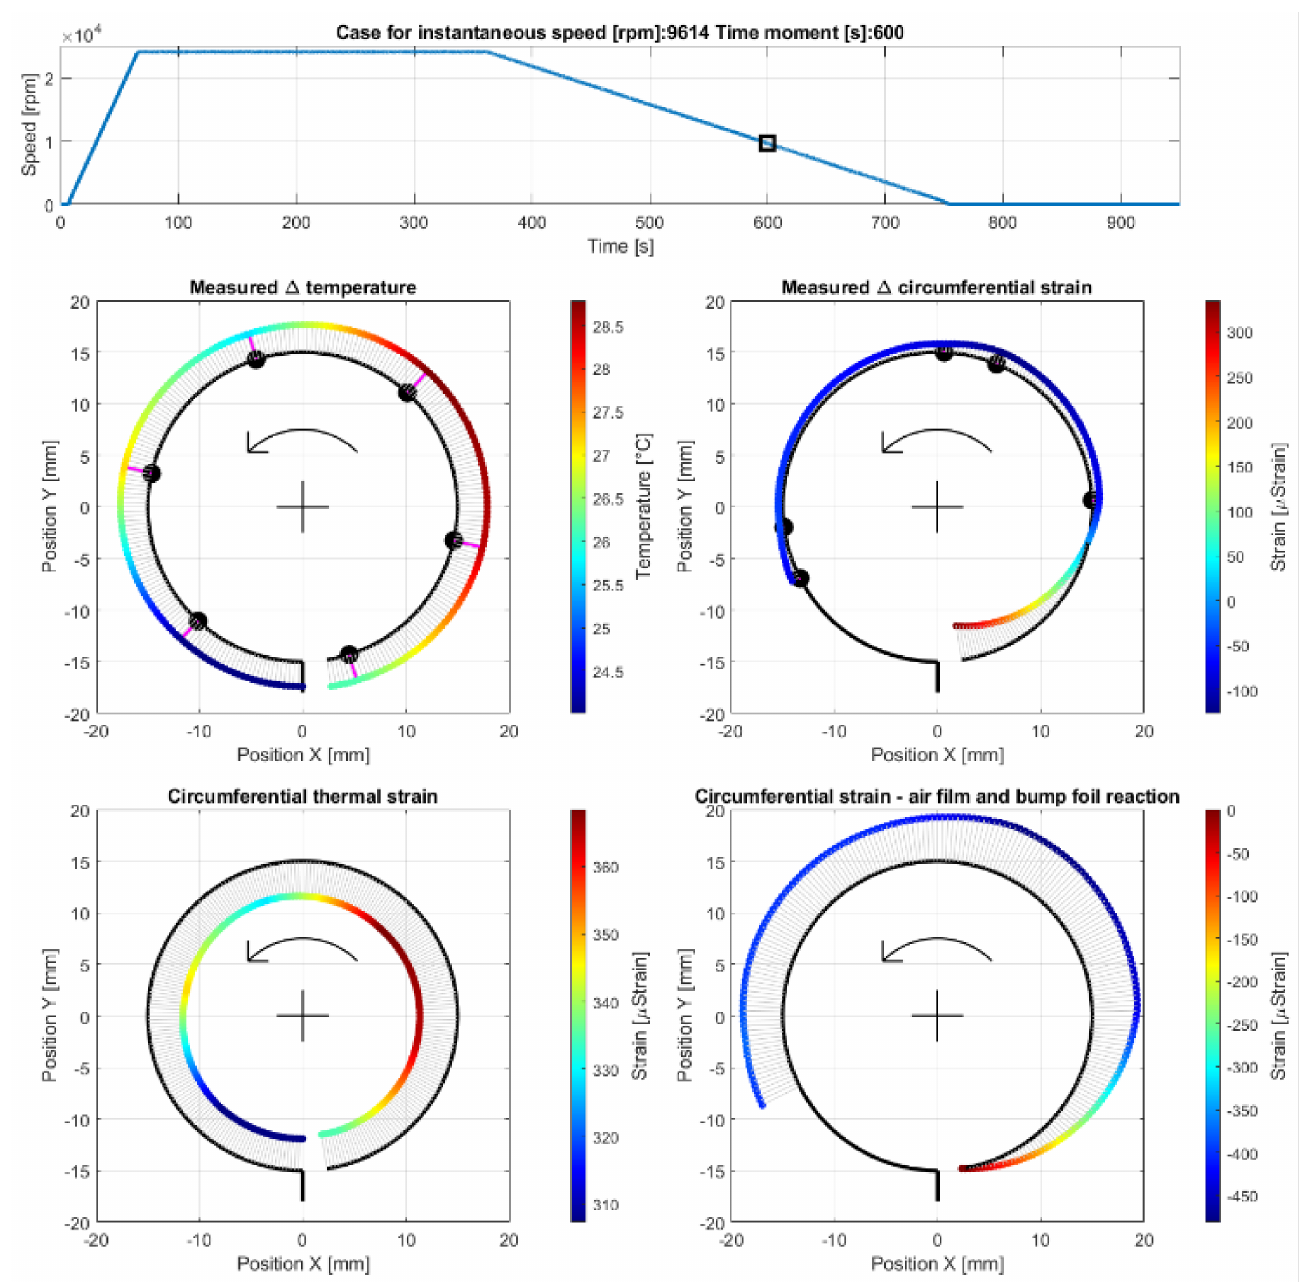
Figure 15. Cross-sectional views for the circumferential distribution of the temperature and strain identified in the top foil at 9614 rpm during the run-out stage of the GFB’s operation before the air film was completely